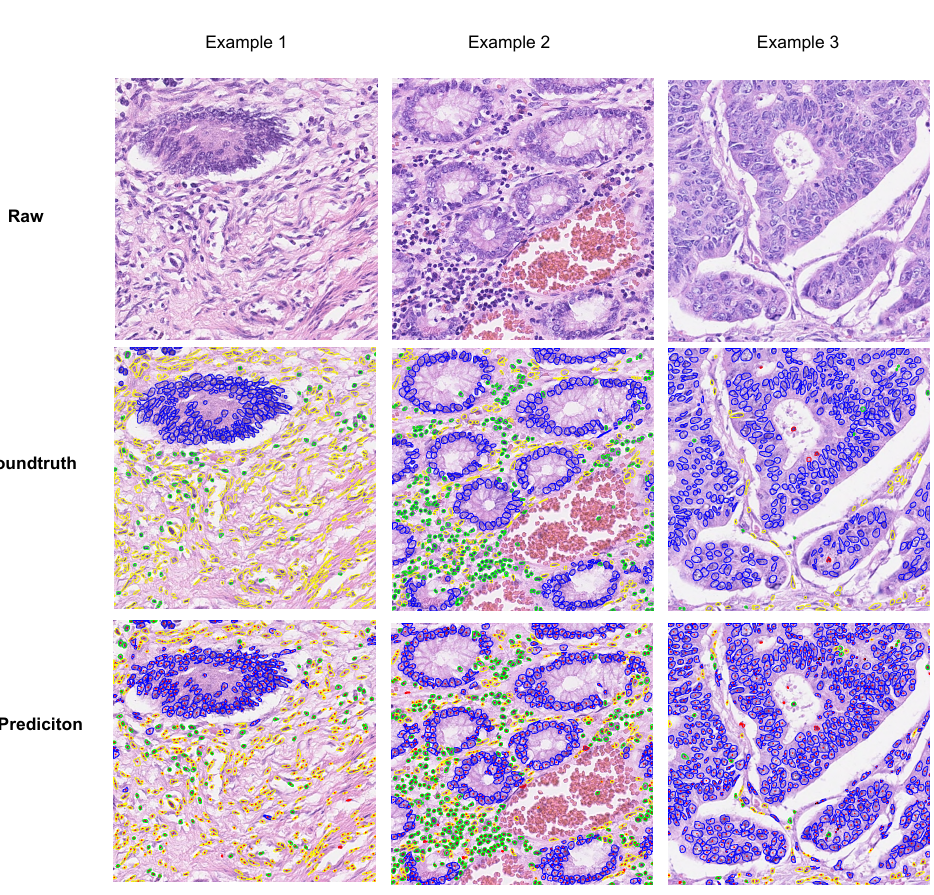
Figure 4. Sample tissue images from the CoNSeP dataset with ground-truth annotations and predic- tion of Mulvernet